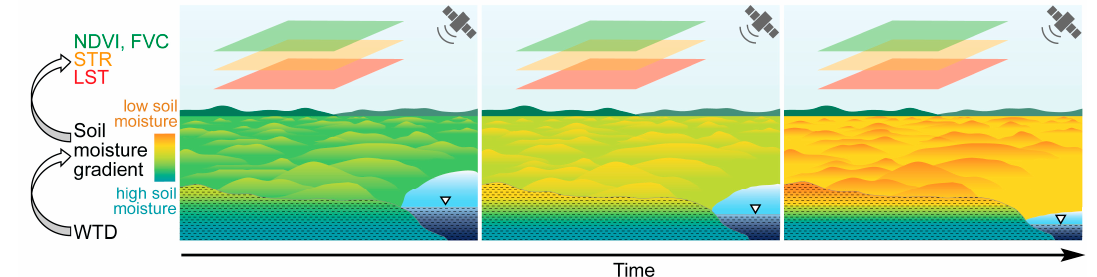
Figure 1. Sketch illustrating the concept of the link between water table depth (WTD) and remotely sensed parameters via the capillary connection between WTD, moisture in the soil, and vegetation. The remotely sensed parameters used in this study: normalized difference vegetation index (NDVI), fractional vegetation cover (FVC), land surface temperature (LST), and shortwave infrared transformed reflectance (STR).